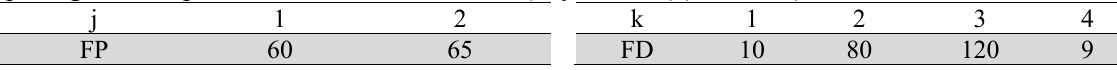
Opening cost for plants and distribution centers(FP j and FD k )( Rial*10 9 )